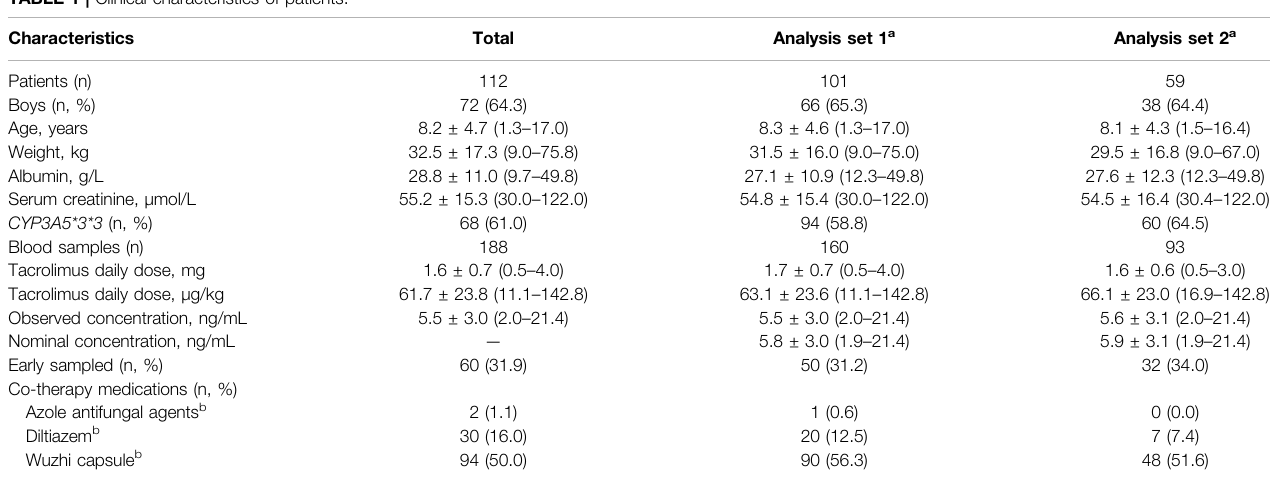
TABLE 1 | Clinical characteristics of